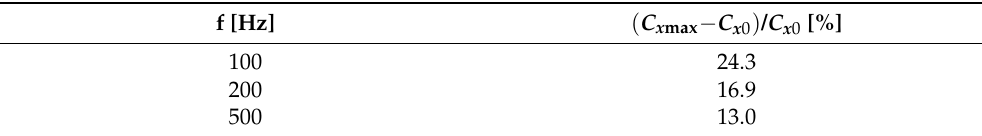
Table 2. The maximum relative change of the capacitance.